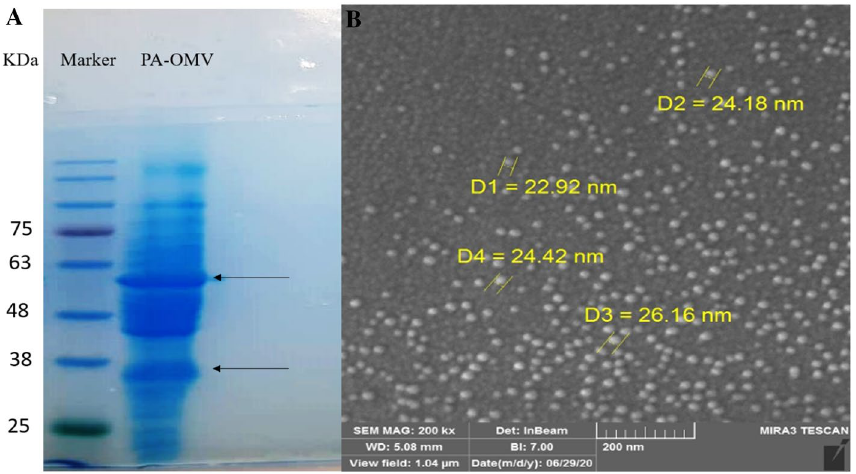
Figure 1. Characterization of PA-OMVs isolated from P. aeruginosa . ( A ) Coomassie brilliant blue-stained SDS– PAGE of PA-OMVs. ( B ) FE-SEM of PAO1 derived